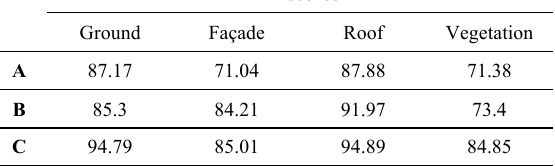
Table 3. Per-class F1 scores for the Bordeaux dataset.